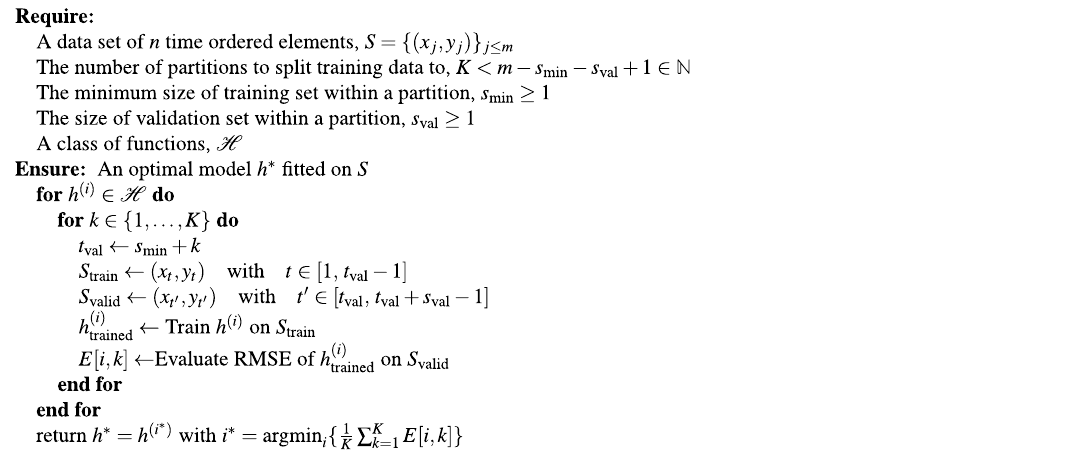
Algorithm 1 iteratively evaluates a class of functions H , in which each function h ( i ) differs from its